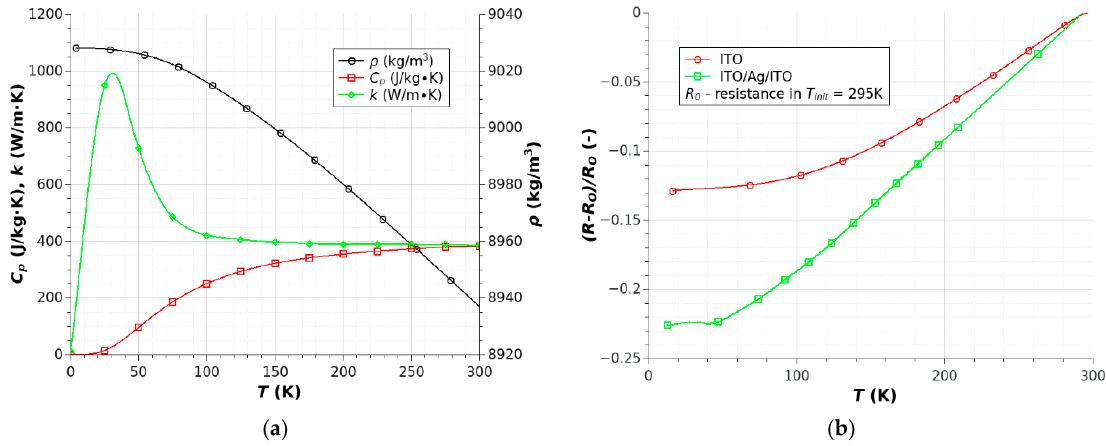
Figure 11. Temperature dependence of material properties: ( a ) copper; ( b ) TCO layers.